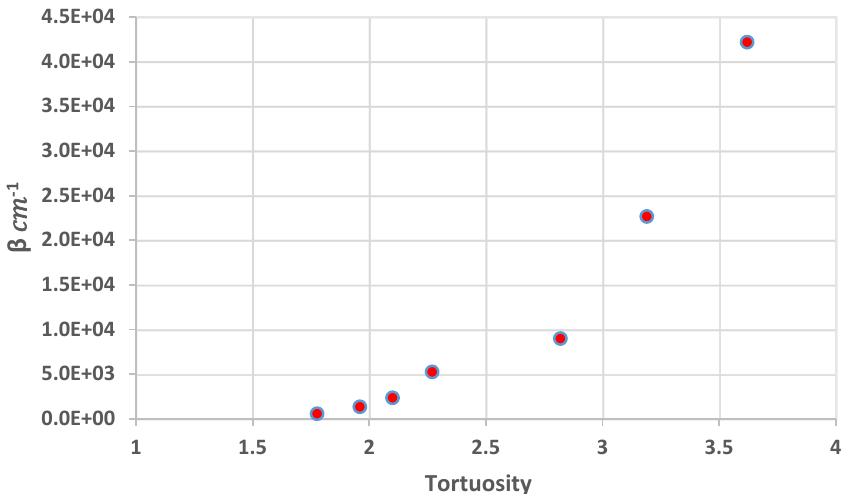
Figure 10. The effect of tortuosity on inertia coefficient β .